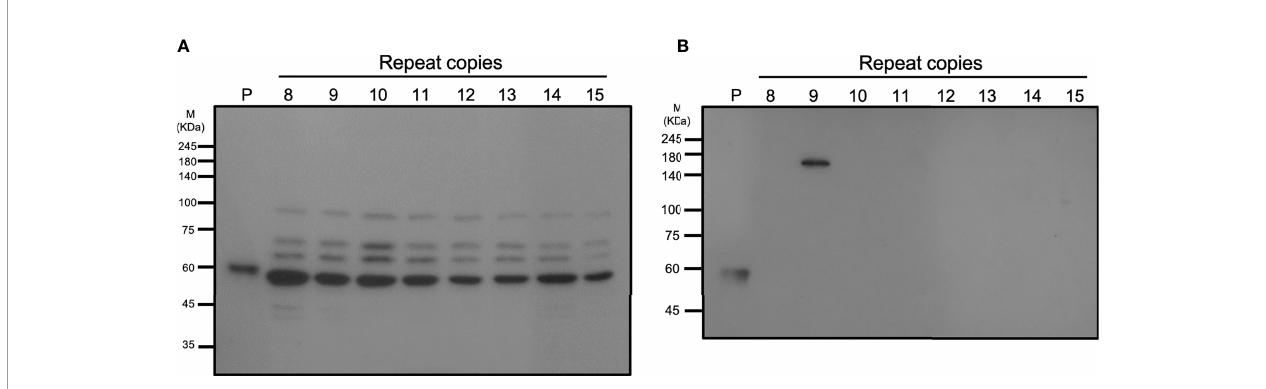
FIGURE 5 | Western blotting analysis of different strains with various repeat copies. (A) shows the total cell lysates, and (B) shows the exoproteins of different